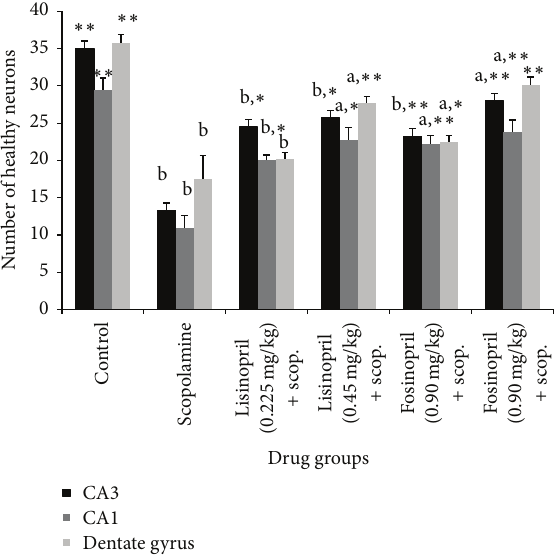
Figure 6: Number of healthy neurons at CA3, CA1, and dentate gyrus regions of the hippocampus of scopolamine treated amnesic rats following treatment with lisinopril and fosinopril. Comparison between control, scopolamine, lisinopril, and fosinopril treated groups in the probe trial of Morris water maze test in which no platform was present. Values are mean ± SE, ∗ versus scopolamine ( 𝑝 < 0.05 ), ∗∗ versus scopolamine ( 𝑝 < 0.001 ), a versus control ( 𝑝 < 0.05 ), and b versus control ( 𝑝 < 0.001